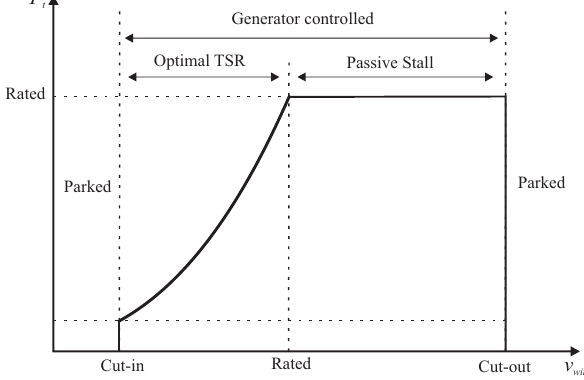
Figure 1. Qualitative mechanical power as a function of wind speed for the VAWTs presented in this paper.